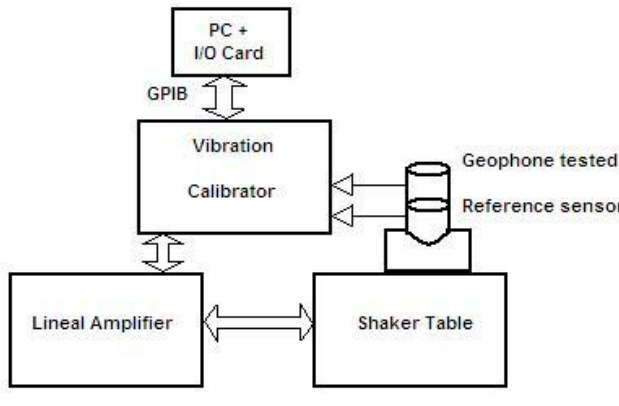
Figure 13. Block diagram of the measurement system.